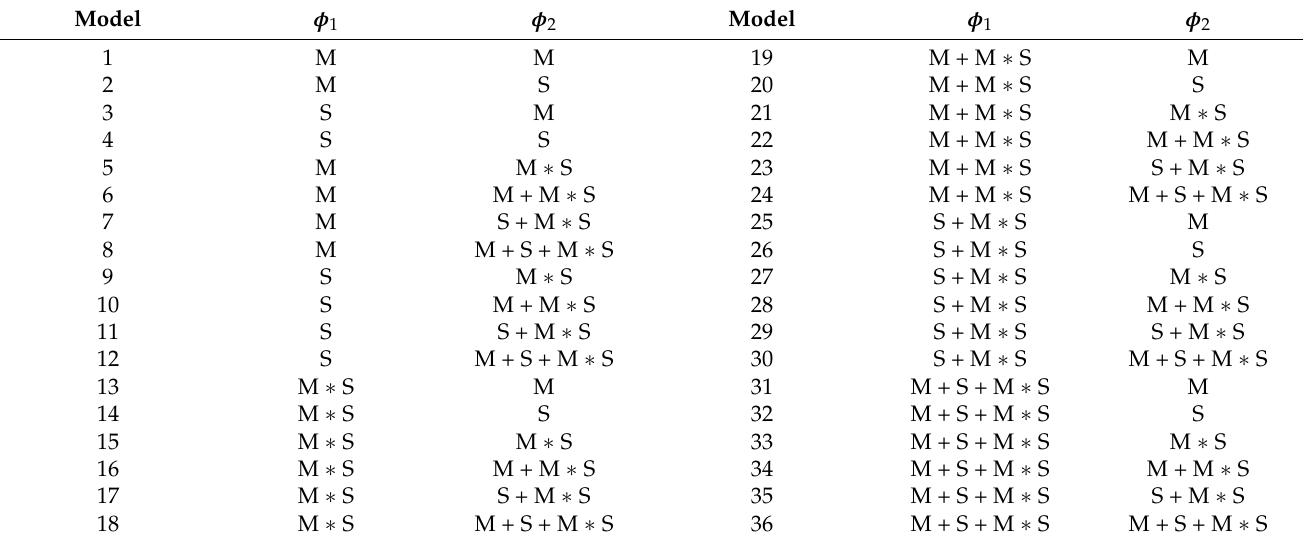
Table 6. Thirty-six alternatives of the random effect constructions in the nonlinear mixed-effects models.